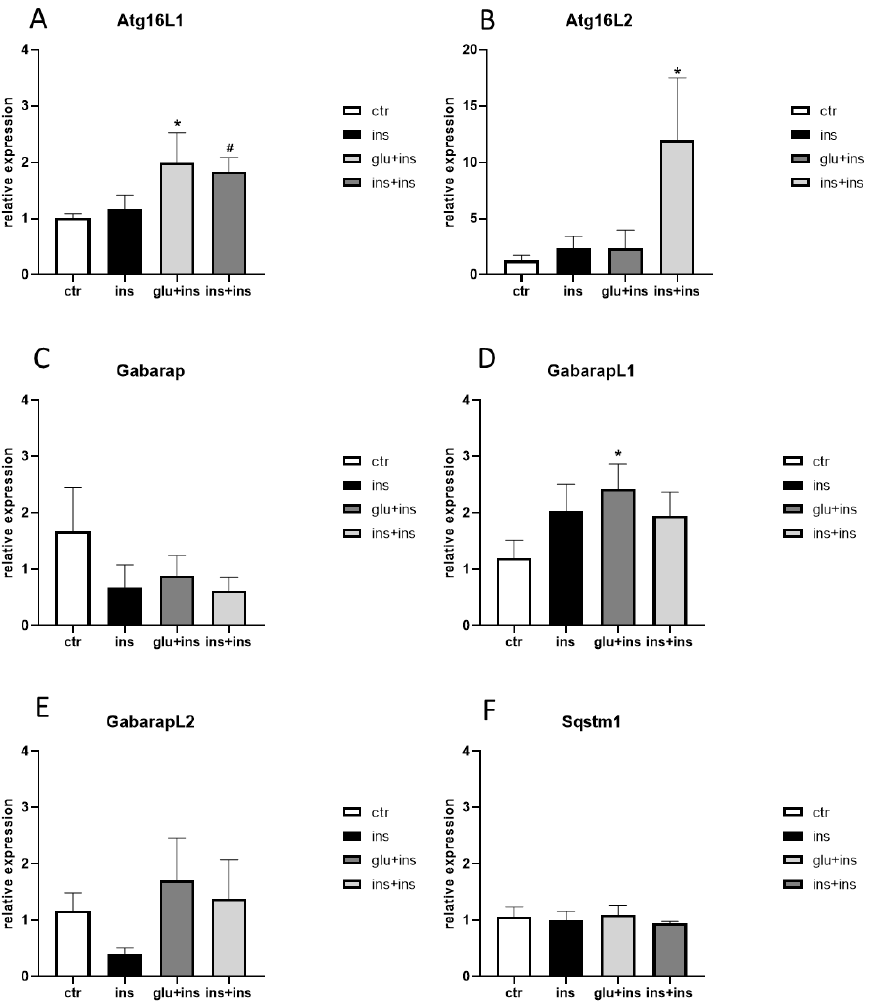
Figure 3. Phospho-Akt/Akt levels in response to insulin challenge (100 nM 30 min) after chronic treatment with 40 mM glucose or 20 nM insulin or vehicle. Sample immunoblot ( A ); protein levels ( B ). ** p < 0.01 vs. ctr; † p < 0.05 vs. ins; †† p < 0.01 vs. ins in Dunnett’s test; n = 4. Int. J. Environ. Res. Public Health 2023 , 20 , 4540 Similar to findings obtained in 3xTg-AD mice, in the presence of insulin resistance, Atg16L1 , Atg16L2 , and GabarapL1 expression levels were significantly increased (Figure 4A,B,D).